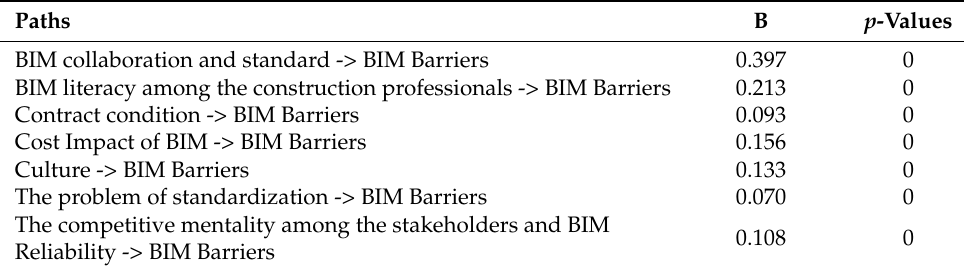
Table 9. Hypothesis and relative path for the model. Paths B p